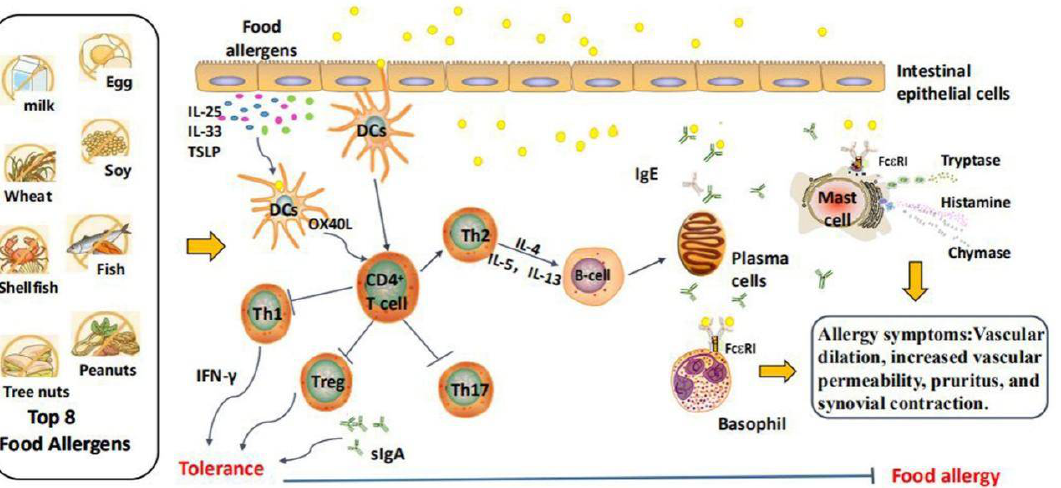
Figure 1. The possible mechanism of food allergy. Food allergens are digested into peptides in the gut through the epithelial barrier, which are captured by DC S and presented to naive CD4 + T cells. Naive CD4 + T cells then differentiate into the Th-2 phenotype, producing IL-4, IL-5, and IL-13. Among them, IL-4 and IL-13 induce B cells to produce allergen-specific IgE antibodies, which bind to Fc ε RI receptors on the surface of basophils and mast cells, triggering degranulation and the release of chemical mediators such as histamine. TSLP: thymic stromal lymphopoietin; I-: